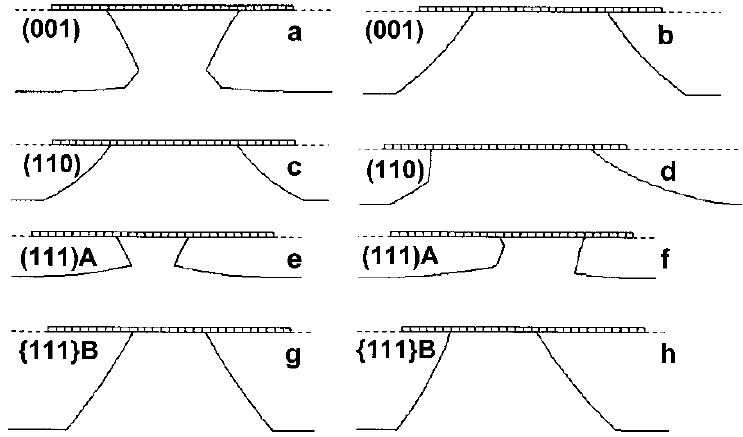
FIGURE 11 Theoretical 2D etching shapes for the cross-sections of grooves etched on surfaces indicated in the figures and aligned along specified directions defined by an angle C A . Dissolution profiles are derived from law 2. For various surfaces the angle C A takes the following values: (a) C A ¼þ 45 (cid:3) , (b) C A ¼(cid:1) 45 (cid:3) , (c, e, g) C A ¼ 0 (cid:3) , (d, f, h) C A ¼(cid:1) 90 (cid:3) . The duration of etching in the case of profiles (c) and (d) is divided by